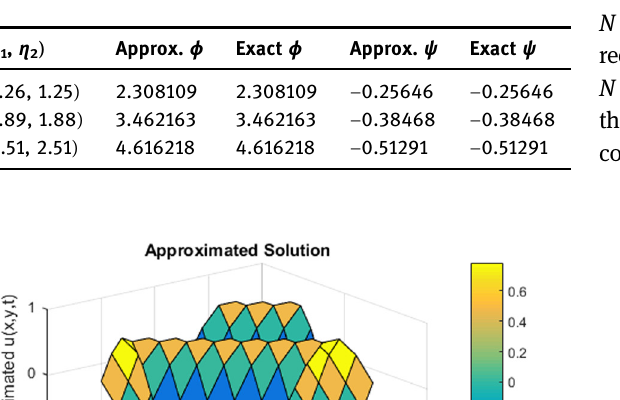
Table 7: Comparison of approximate and exact results at di ff erent mesh points regarding Example 2